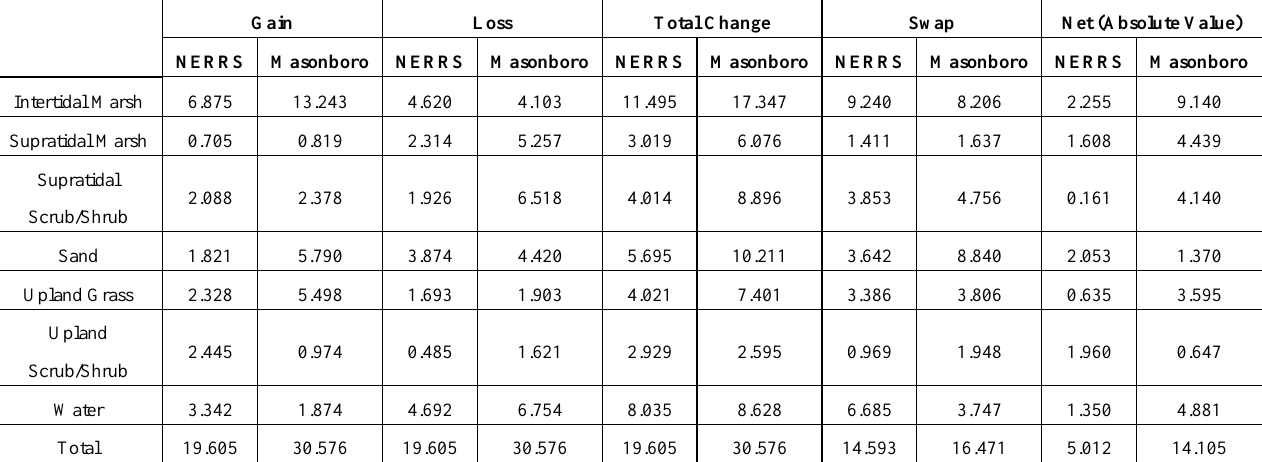
Table 5. Percent change of each habitat type across the NERRS study area and at Masonboro Island.